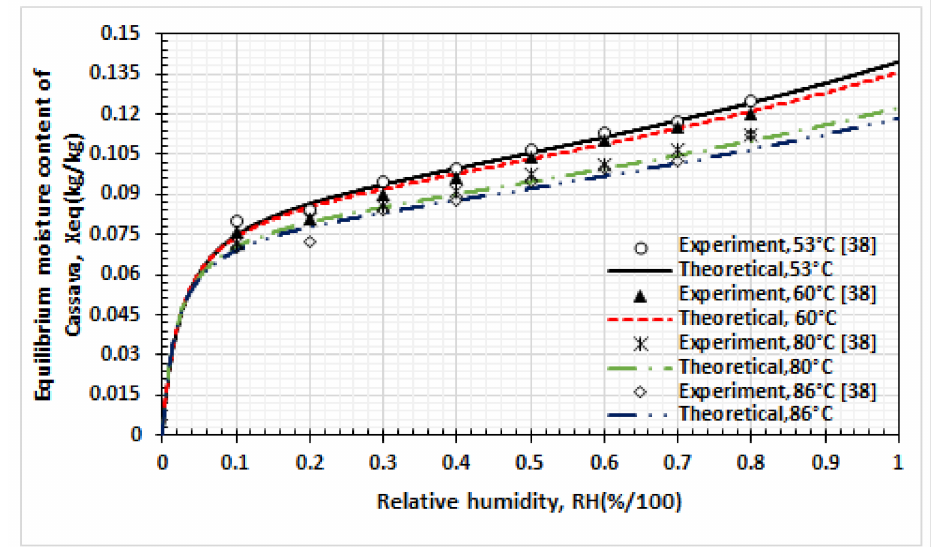
Figure 4. Validation of four curves of desorption isotherms of cassava roots using the parameters of Table 2 at temperatures of 53, 60, 80, and 86 ◦